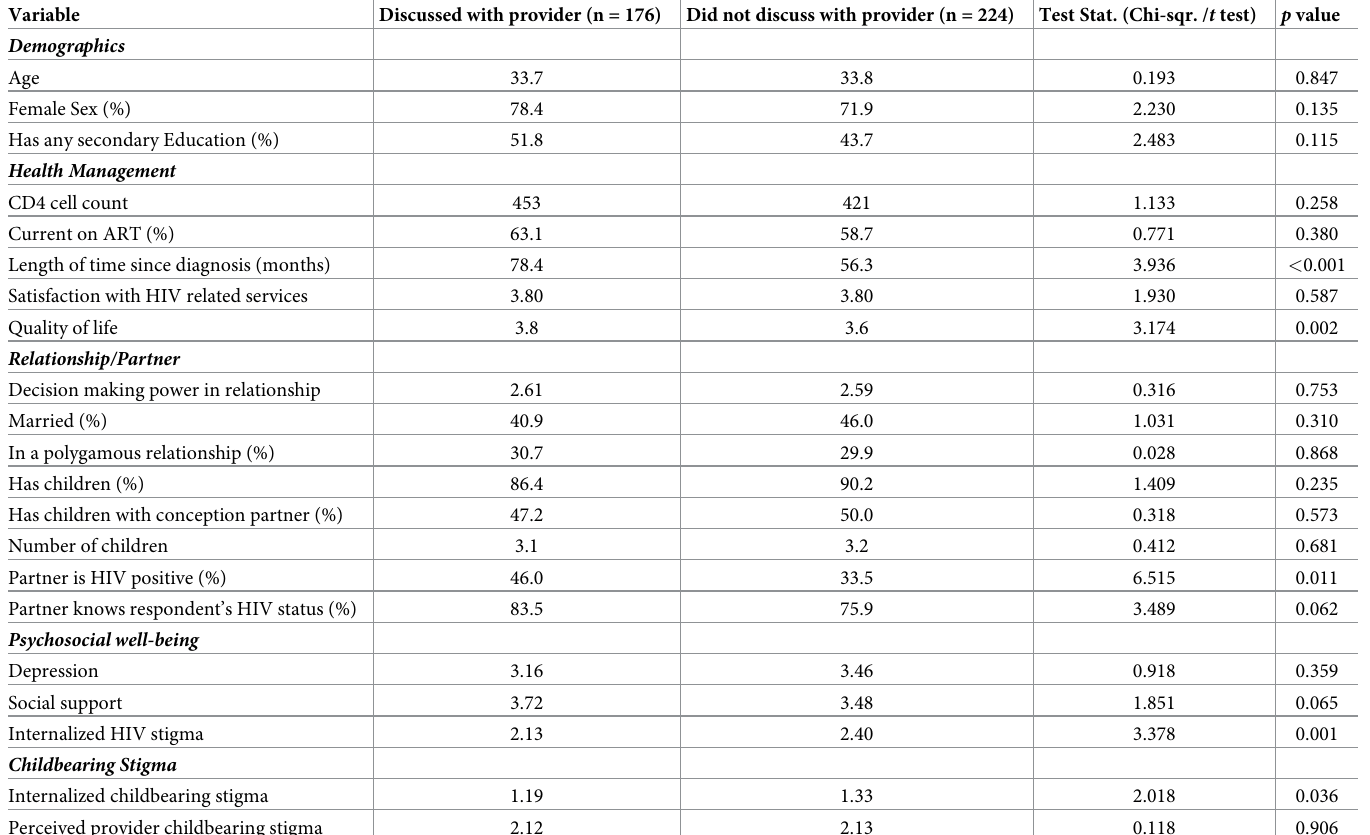
Table 2. Correlates of communication with HIV provider(s) about childbearing intentions.